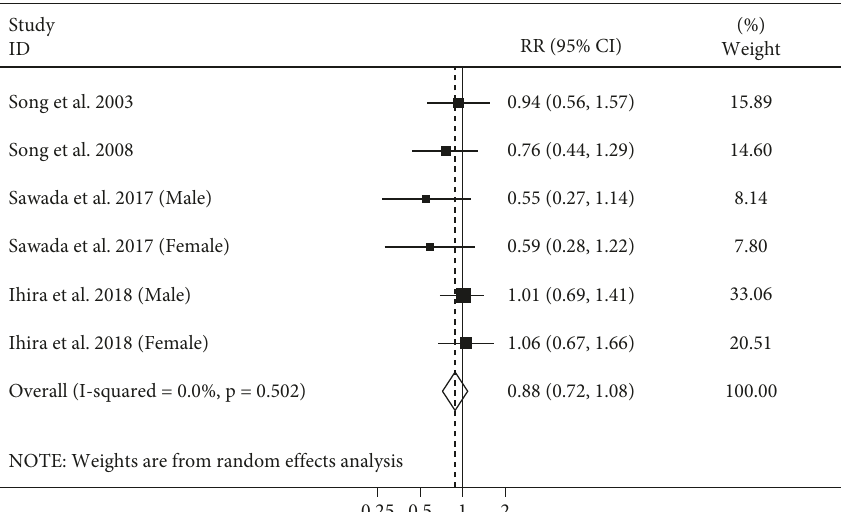
Figure 5: Forest plot for the association between adult height and risk of ischemic stroke mortality by comparing the highest and lowest height. Horizontal lines represent 95% CIs. Diamonds represent the pooled estimates from the random-effects analysis. RR: relative risk; CI: confidence interval.